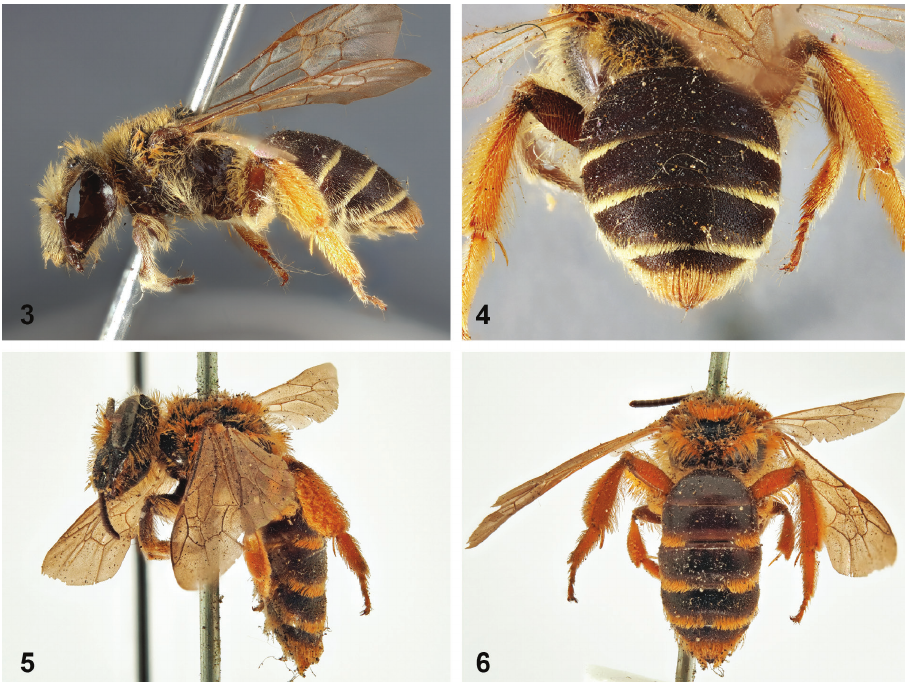
Figures 3–6. 3, 4 Lectotype female of Andrena afzeliella (Kirby, 1802) 3 profile 4 terga and terminal fringe. Copyright for these two images belongs to the trustees of the Natural History Museum, London 5, 6 lectotype female of A. russula Lepeletier, 1841 5 profile 6